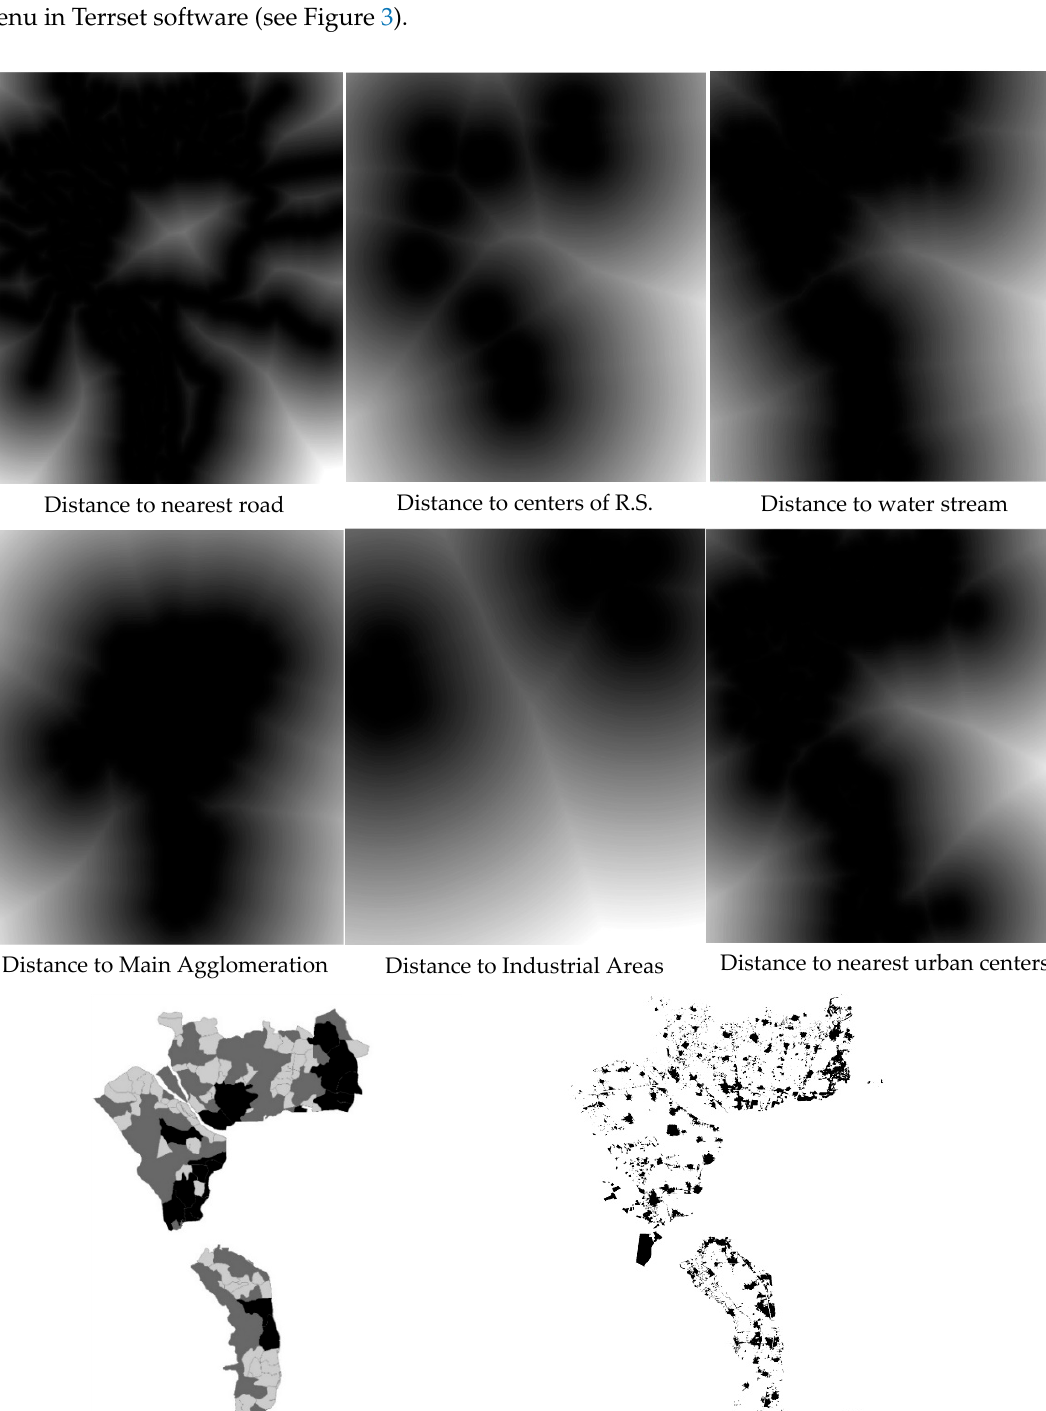
Figure 2. Dependent variable (Y): the change to urban area from 2007 to 2017.